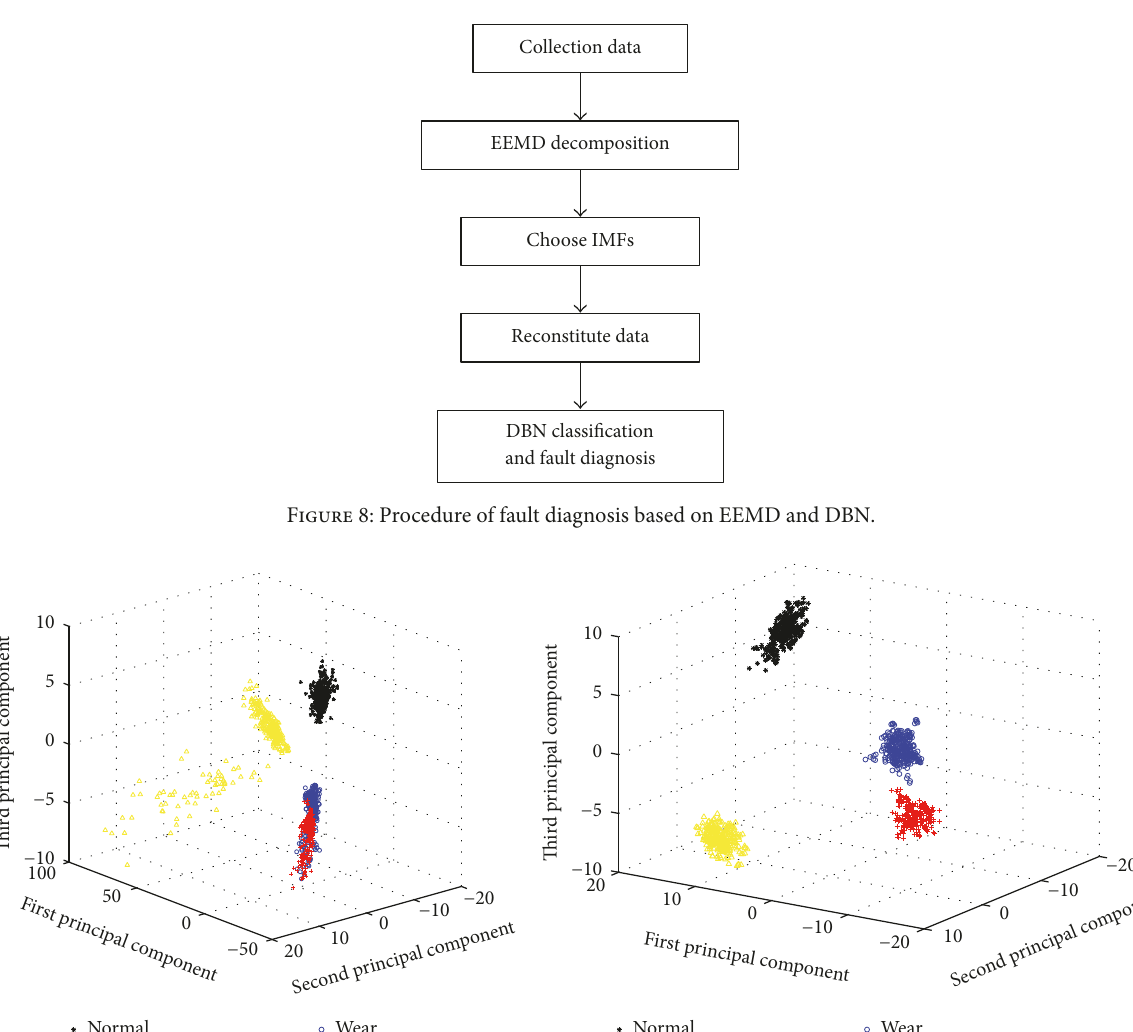
Figure 7: EEMD results of fault signal.